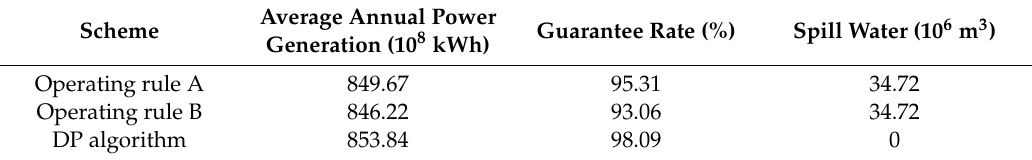
Table 2. Comparison of simulation results of three schemes (the operation horizon is